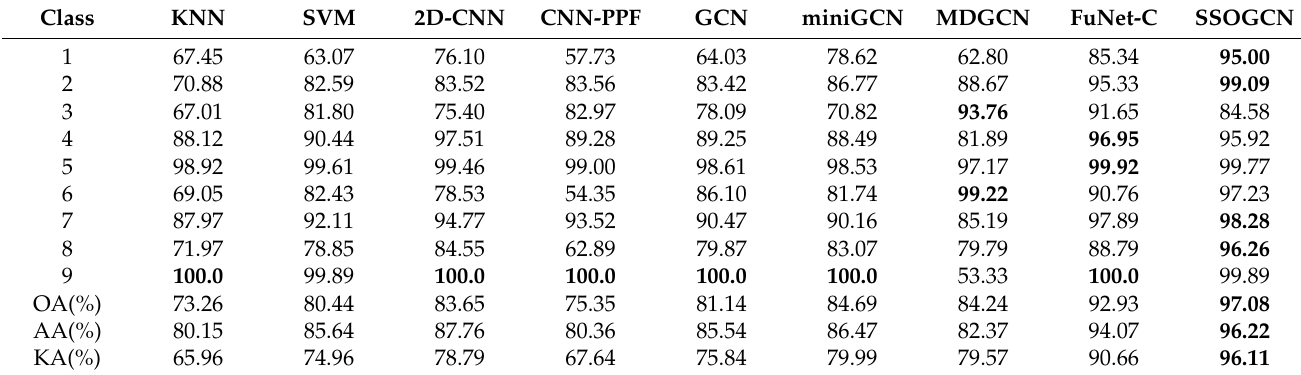
Table 6. Classification performance of various algorithms in Pavia University data set (%).